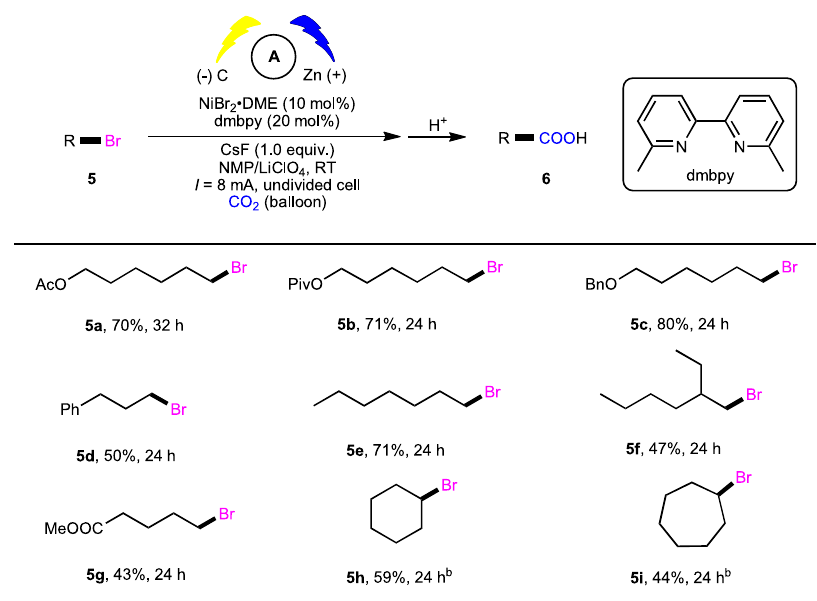
Fig. 3 Scope of alkyl bromides. a Reaction conditions, see more details in “ Supplementary information ” . b I = 4